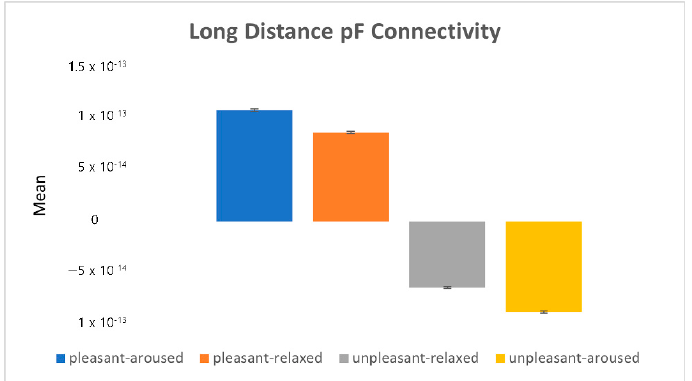
Figure 17. The eigenvalues in the long-distance prefrontal connectivity.